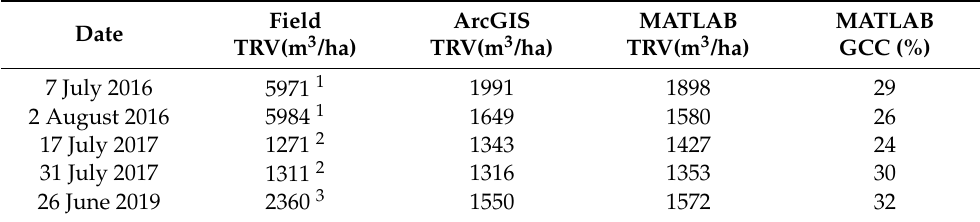
Table 2. The Tree-Row-Volume (TRV) field measurements compared with the grapevine volumes calculated by ArcGIS and MATLAB, and the Green Canopy Cover (GCC), at five different dates.